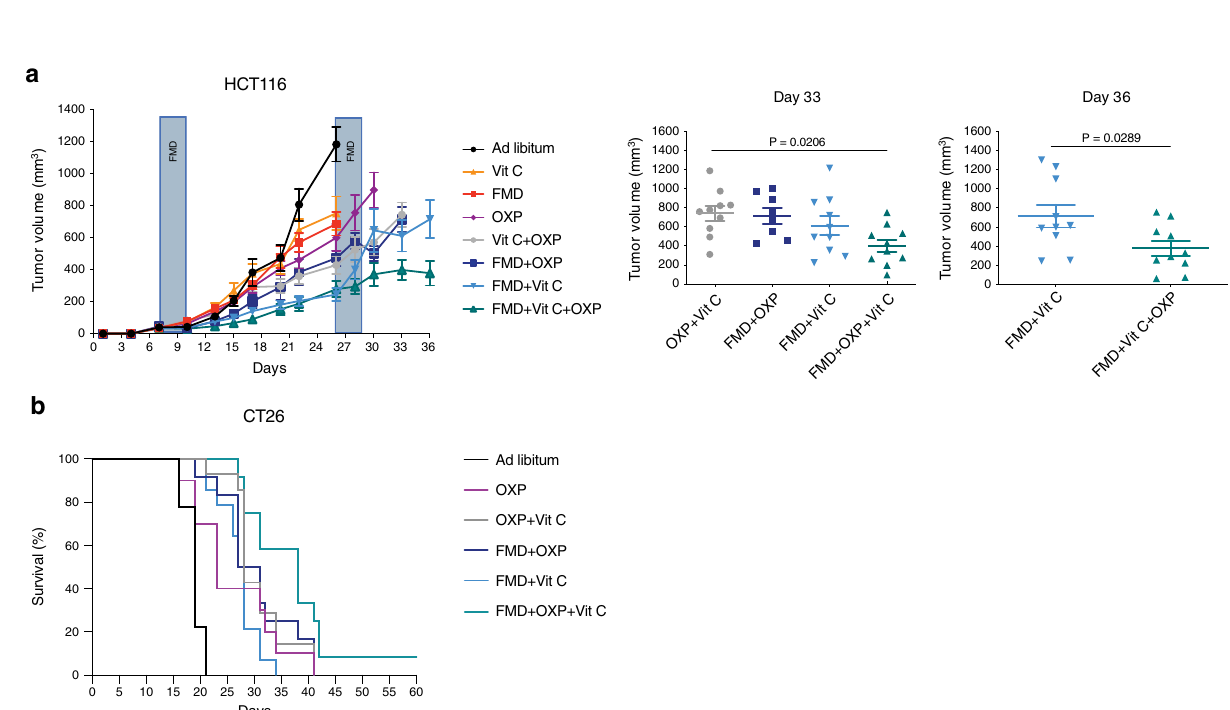
Fig. 4 HO-1 modulation and iron-bound transferrin are the key players in FMD-dependent sensitization to Vitamin C. a , b Western blotting detection of HO-1 expression level in KRAS -mutant HCT116 ( n = 4), CT26 ( n = 4) and HCT116-derived tumor masses ( n = 5 in Vit C and FMD + Vit C, n = 7 in Ad libitum and FMD) and KRAS -wild-type SW48 cancer cells ( n = 4). VINCULIN as loading control. Representative blots and quanti fi cations are shown. P values were determined by two-sided unpaired t -test. CT26: exact P values = 0.00002 (CTR vs STS), 0.00009 (CTR vs STS + Vit C). c Viability of DLD1, HCT116, and CT26 cells treated with STS with or without vitamin C, hemin ( n = 3) or d zinc protoporphyrin (ZnPP; HCT116, n = 3; DLD1 and CT26, n = 4). P values were determined by two-sided unpaired t -test. HCT116 in ( c ): exact P value = 0.00005 (STS + Vit C vs STS + Hemin + Vit C), CT26 in ( c ): exact P value = 0.00001 (STS + Vit C vs STS + Hemin + Vit C). e Western blot (left) and viability (right) of HCT116 cells transfected with control siRNAs (siCTR) or anti-HO-1 siRNAs (siHO-1), n = 5. P values were determined by two-sided unpaired t -test. f Viability of HCT116 cells grown in STS medium with apo-transferrin (ApoTrf) or holo-transferrin (HoloTrf) with or without vitamin C ( n = 4 in STS, n = 3 in ApoTrf and n = 5 in HoloTrf). P values were determined by two-sided unpaired t -test. Exact P value = 0.00000003 (STS + Vit C vs STS + HoloTrf + Vit C). g Quanti fi cation of transferrin bound iron in mouse blood serum (right) of HCT116-engrafted NSG mice fed ad libitum or subjected to FMD cycles, and treated with or without vitamin C (tumor growth, left). Black arrows indicate blood serum collection: upon the last FMD cycle and 24 h after refeeding (RF). P values were determined by two-sided unpaired t -test ( n = 8 mice in Ad libitum, n = 7 in FMD, FMD + Vit C, Vit C, n = 3 in FMD RF, FMD + Vit C RF). All data are represented as mean ± SEM, n =